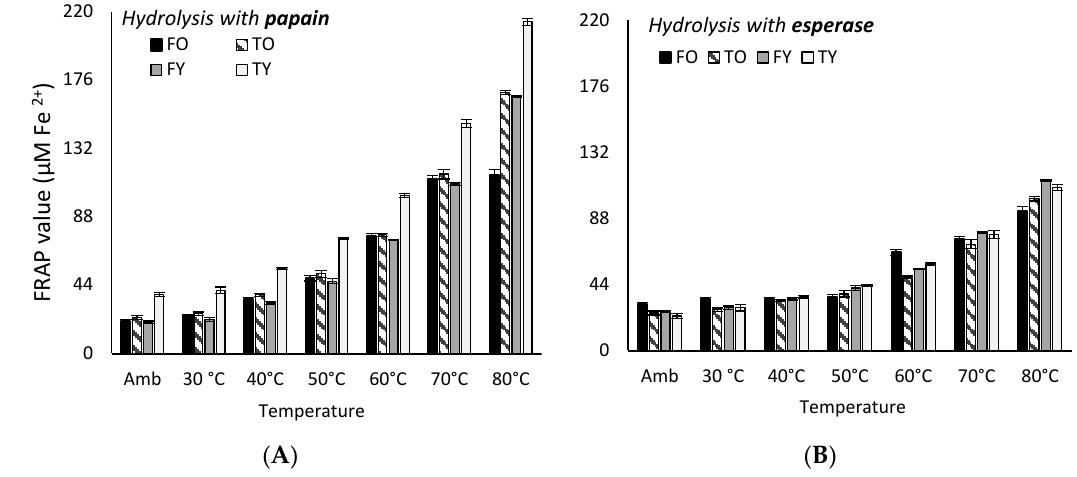
Figure 3. Highest ( A ) and lowest ( B ) FRAP values ( µ M Fe 2 + ) for collagen peptides solutions ( < 3000 Da) obtained through papain and esperase, respectively, at increasing temperatures. FO = old femur, 10 years; TO = old tibia, 10 years; FY = young femur, 4.5 years; TY = young tibia, 4.5 years. Table 1. FRAP index (mean values) at 80 ◦ C for each enzyme, expressed as mmol of electrons donated per 100 g of peptides solution. FO = old femur, 10 years; TO = old tibia, 10 years; FY = young femur, 4.5 years; TY = young tibia, 4.5 years.